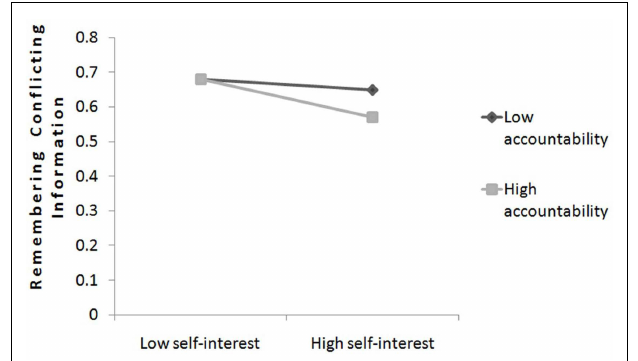
FIGURE 6 |The relationship between self-interest and remembering conflicting information as a function of advisor’s perceived accountability (study